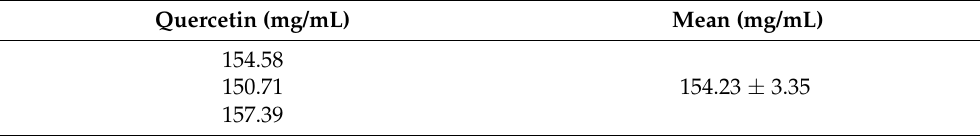
Table 3. Total flavonoids determination of C. aconitifolius ethyl acetate